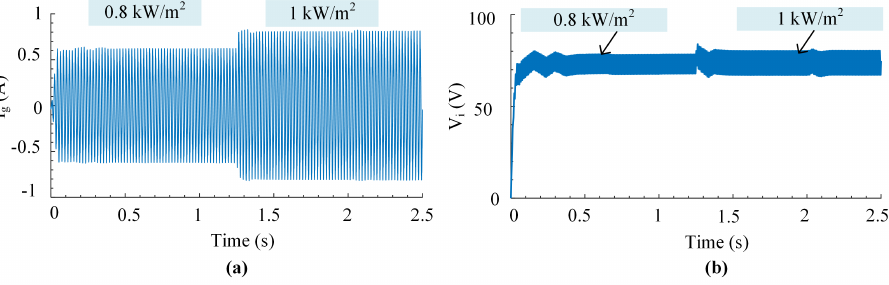
Figure 12. ( a ) Variation in the output current I g . ( b ) Variation in input voltage V i with respect to changes in irradiation